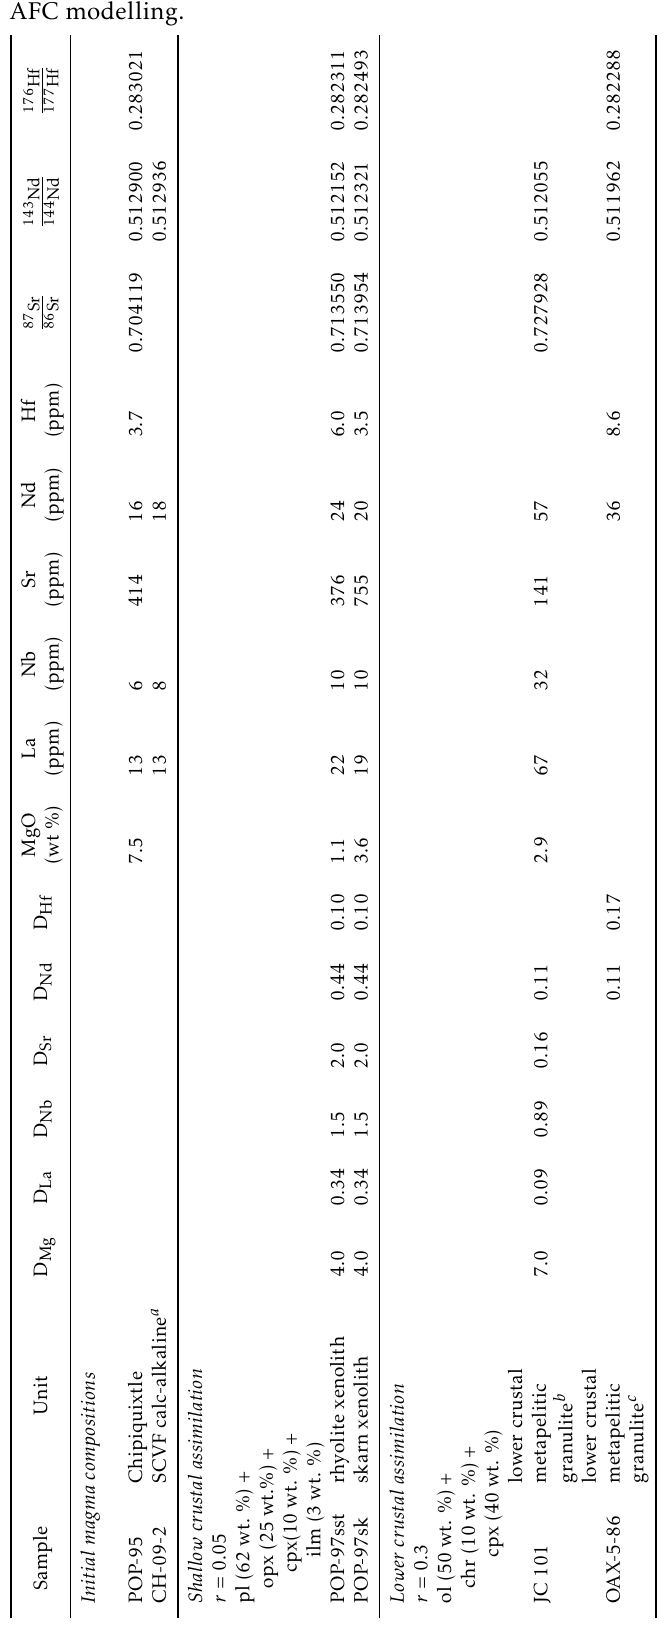
Table 2 – Endmembers and modelling parameters used for AFC